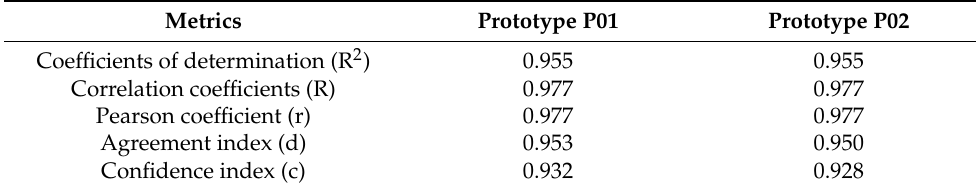
Table 6. Summary of statistical indices for prototypes P01 and P02 after the calibration process.